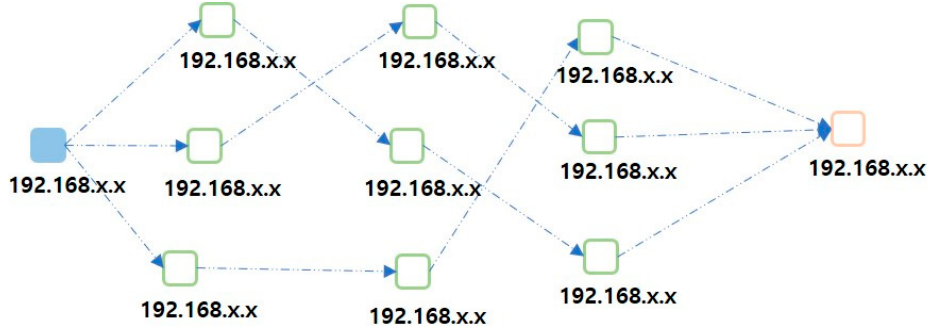
Figure 4. Structure of the simplified DAG-based blockchain.